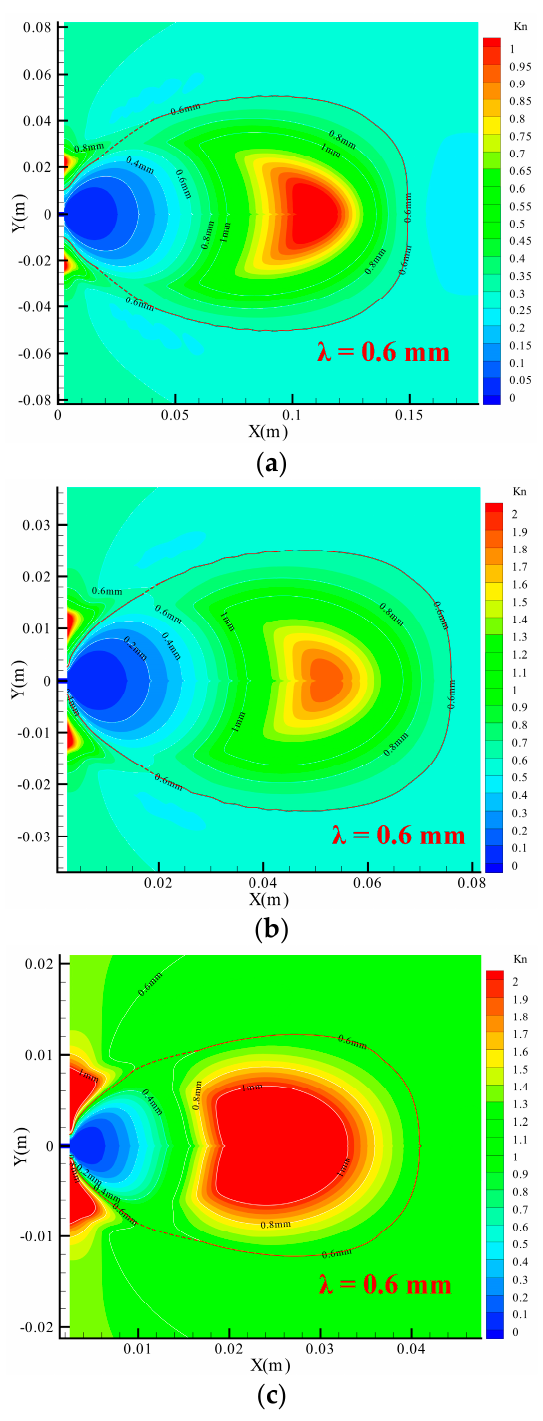
Figure 11. Kn contour with λ contour map of different leak hole diameter (The red line marked in the figure represents λ = 0.6mm and the dotted line is an imaginary line to fix the discontinuity). ( a ) 2 mm; ( b ) 1 mm; ( c ) 0.5 mm.